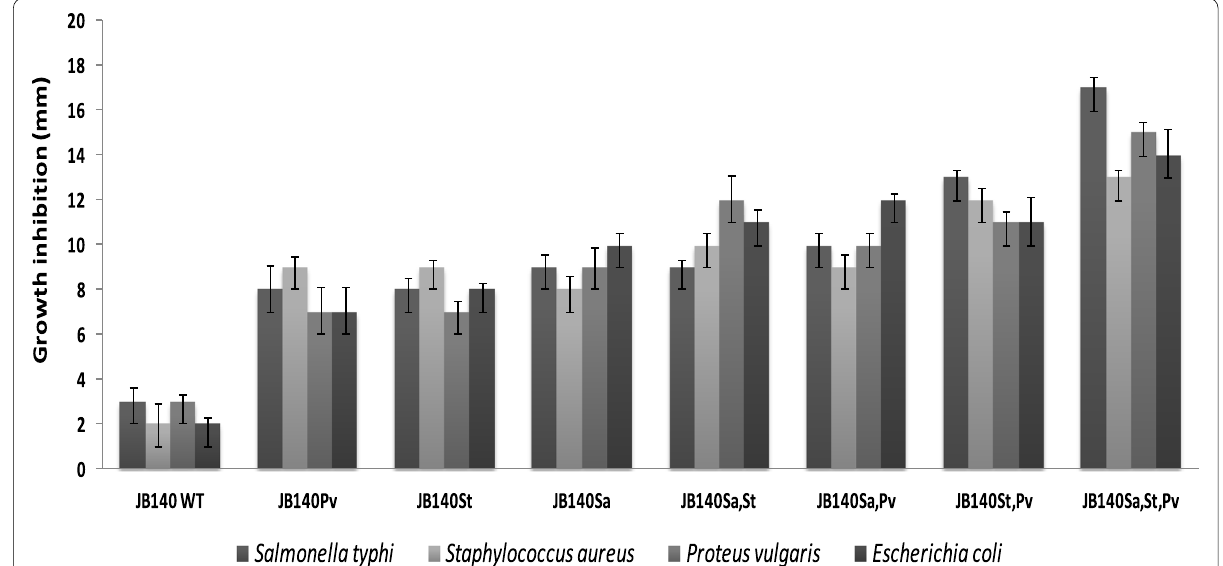
Fig. 8 The antimicrobial response of JB140 WT and evolved mutants JB140 Pv , JB140 St , JB140 Sa , JB140 Sa,St , JB140 Sa,Pv , JB140 St,Pv , and JB140 Sa,St,Pv against Salmonella Typhi, Staphylococcus aureus , Proteus vulgaris, and a clinical MDR uropathogenic Escherichia coli isolate after heat treatment at 90 o C. The methanolic extracts were prepared from 9-day grown cultivation